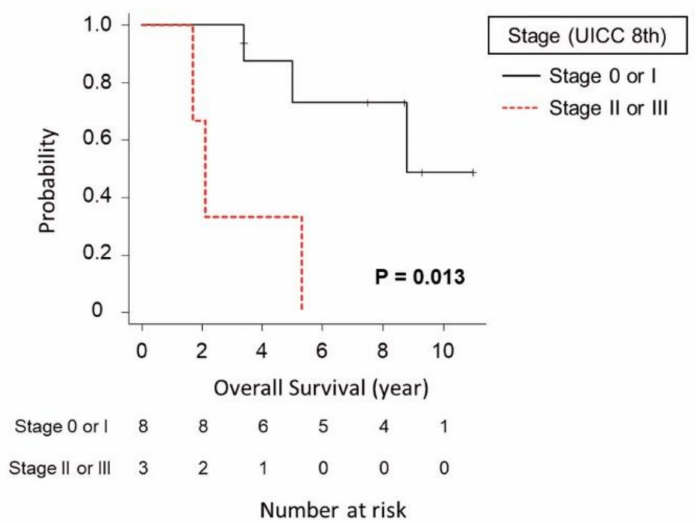
Figure 4. Comparison of overall survival between patients with neoplastic progression who were diagnosed with stage 0 or I disease and those who were diagnosed with stage II or III disease. The median overall survival time of the eight patients who were diagnosed with UICC stage 0 or I disease was significantly longer than that of the three patients who were diagnosed with UICC stage II or III disease (8.8 years vs. 2.1 years ( p =